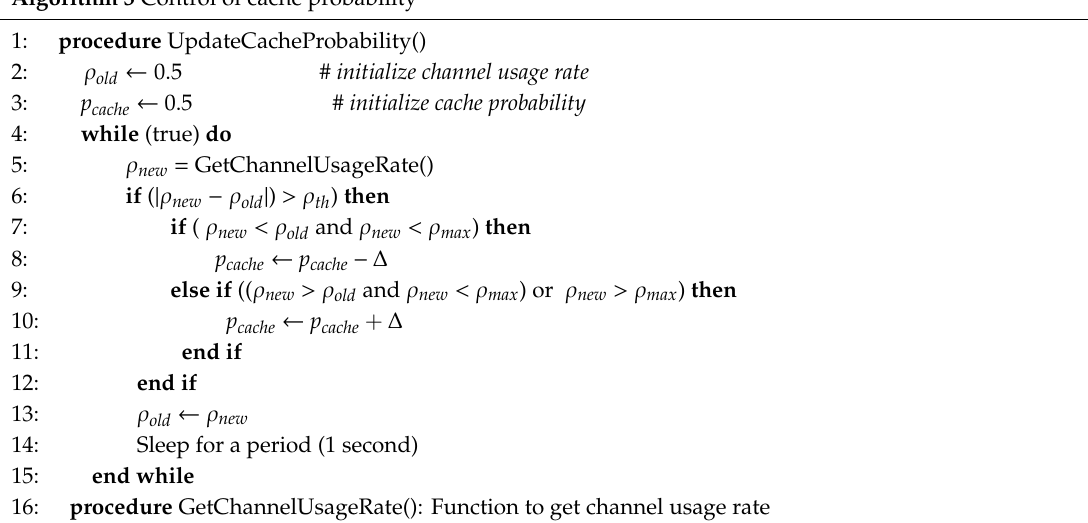
Algorithm 3 Control of cache